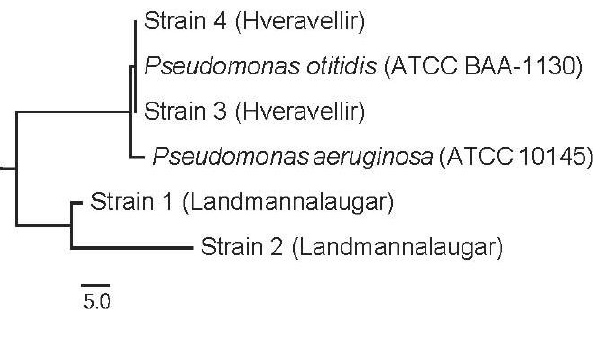
Figure 3. Phylogenetic tree based on neighbor-joining analysis of the 16S rRNA gene sequences of 4 putative Pseudomonas strains. The 16S rRNA sequence of Aquifex was used as an outgroup. The scale bar represents the expected % of substitutions per nucleotide